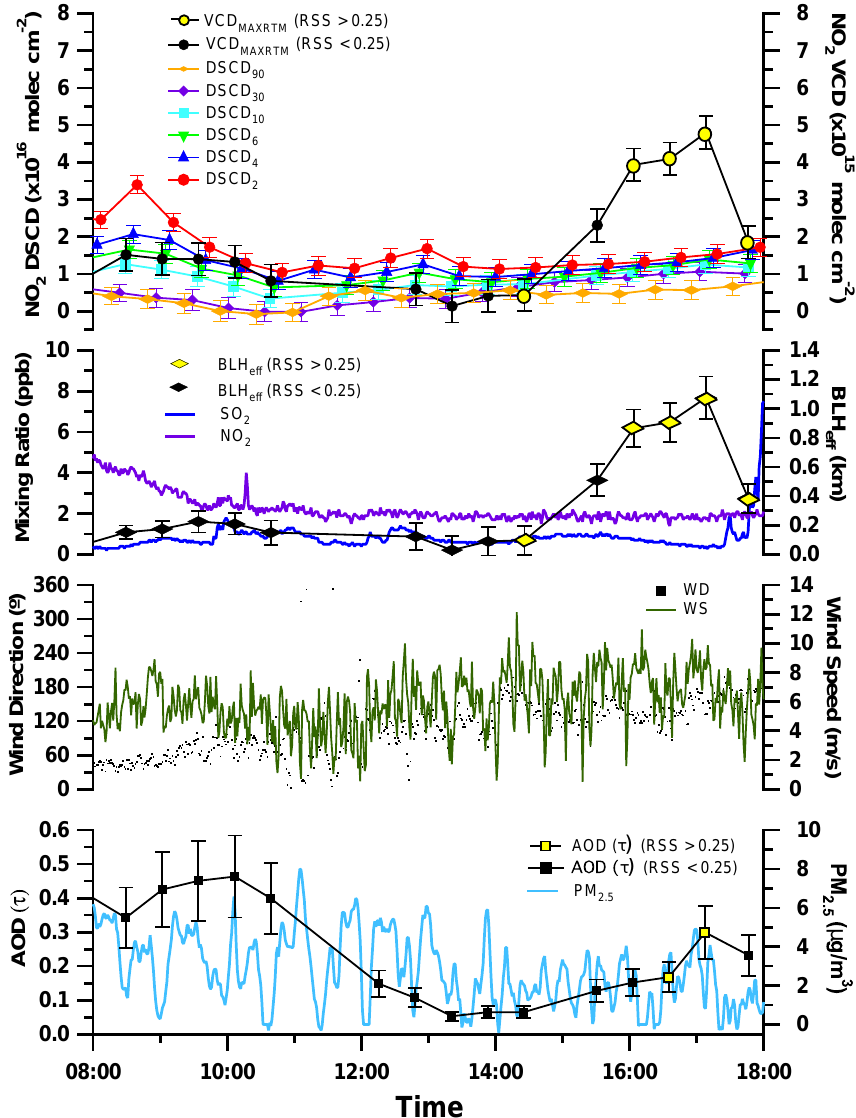
Time Fig. 15. Measurements at Ridgetown on 2 July 2007. NO 2 MAX-DOAS DSCDs with NO 2 VCD RTM values are followed by ground level measurements of SO 2 and NO 2 , BLH eff , wind direction, wind speed, PM 2 . 5 , and AOD ( τ RTM ). edge of a lake breeze, that is still not completely understood. of the day, as was O 3 ( < 35 ppb, not shown). The MAX- DOAS measurements indicated a clean troposphere with VCDs < 2 × 10 15 molec cm − 2 and BLH eff < 200 m prior to 15:00 EDT, indicating either a shallow or inhomogeneously mixed boundary layer with NO 2 confined to the surface. By late morning and throughout the afternoon, the site was experiencing a moderate lake breeze from the S–SE Figure 15 summarizes measurements made on (Lake Erie) although satellite imagery indicates that upper 2 July 2007. The area was under the influence of a re- air movement was from the W–NW. After 15:00 EDT, gional high pressure system on this day with light winds, the VCDs of NO 2 showed an appreciable increase from sunshine, cool temperatures ( < 21 ◦ C) and low deformation ∼ 5 × 10 14 molec cm − 2 up to 5 × 10 15 molec cm − 2 , while the lake breeze conditions (Sills et al., 2011). Ground level BLH eff increased from less than 100 m to greater than 1 pollution (SO 2 , NO 2 , PM 2 . 5 , O 3 ) was low throughout most